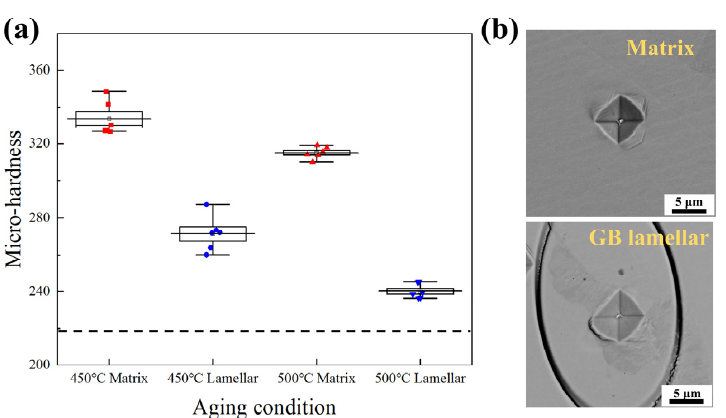
Figure 3. The Vickers hardness test. ( a ) The hardness values in grain interior and lamellar structures near GBs after aging for 10 min, as compared with that of solution-treated specimens (dash line); ( b ) Illustrations of the indentations in matrix and GB lamellar regions. The FIB technique was used to mark the lamellar regions before the tests.